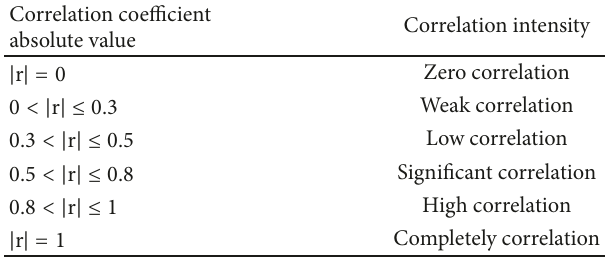
Table 3: Correlation coefficient and correlation intensity.